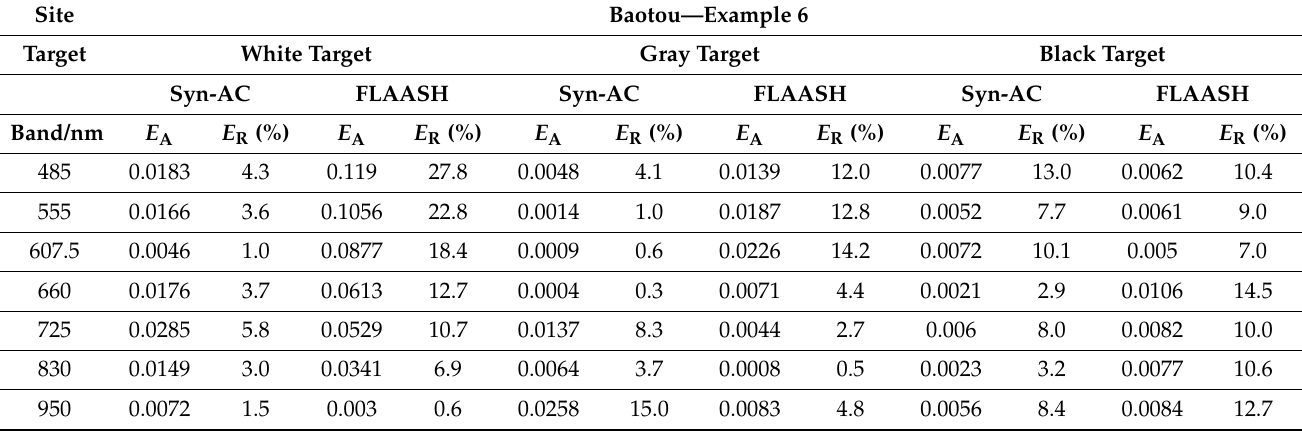
Table 13. Performance comparison between Syn-AC and FLAASH, based on Example 6. Site Baotou—Example